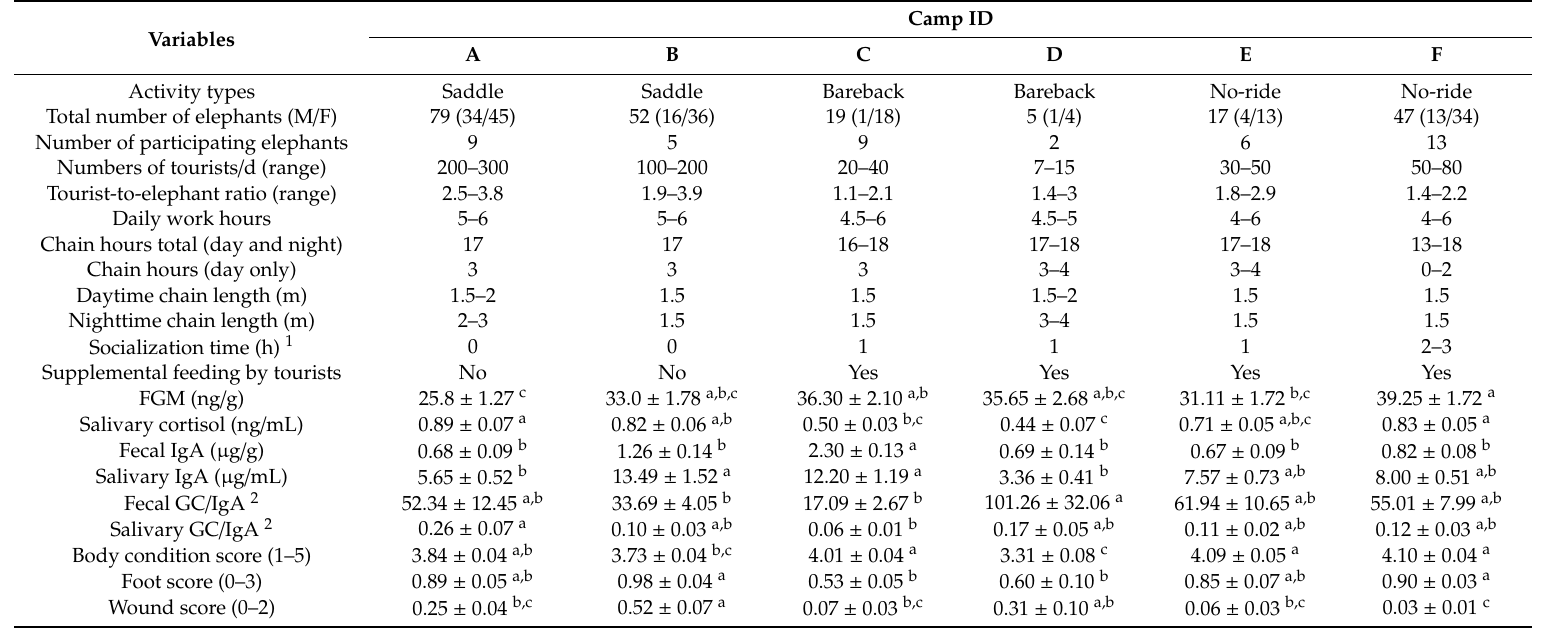
a,b,c Di ff erent superscripts denote statistical di ff erences ( p < 0.05) across rows for each variable. 1 Amount of time elephants were free during the day to socialize with conspecifics. 2 Ratios were calculated within the same biological sample and averaged across all elephants at a